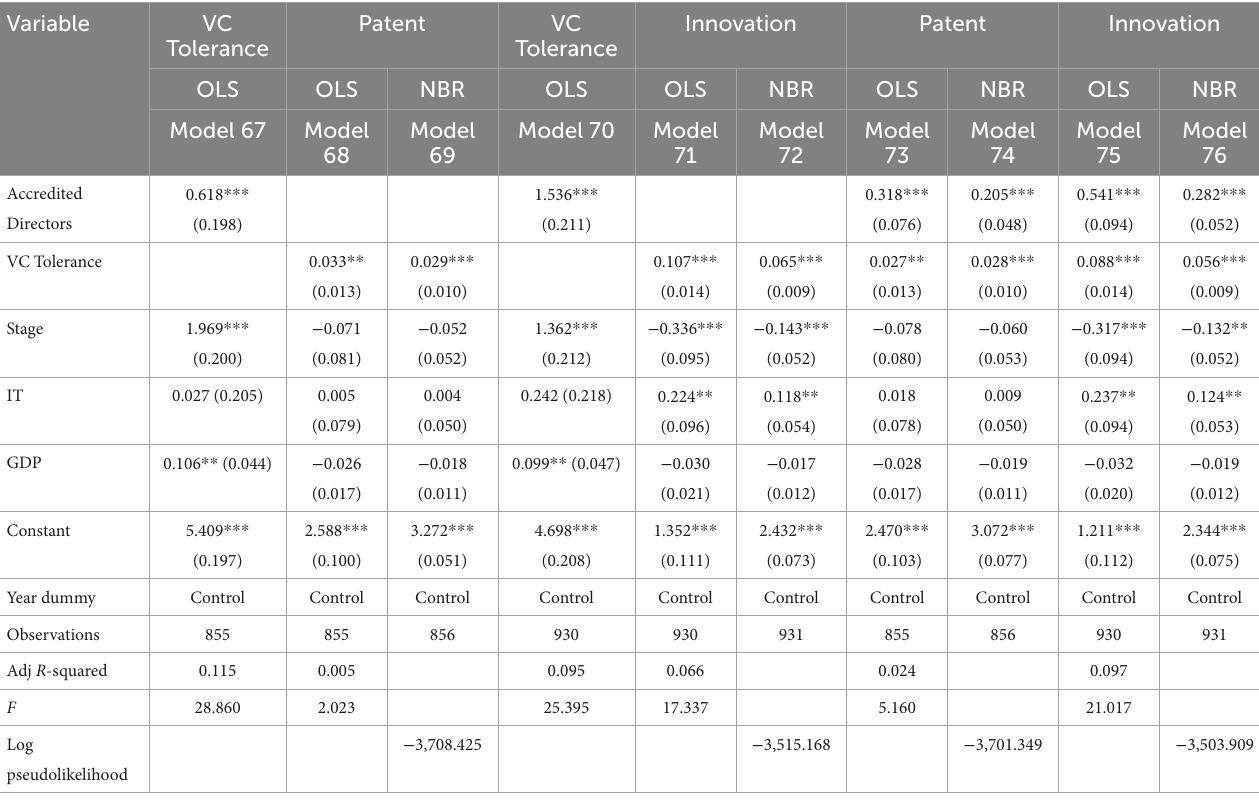
TABLE 13 Impact of dispatched directors and failure tolerance of venture capital on enterprise innovation